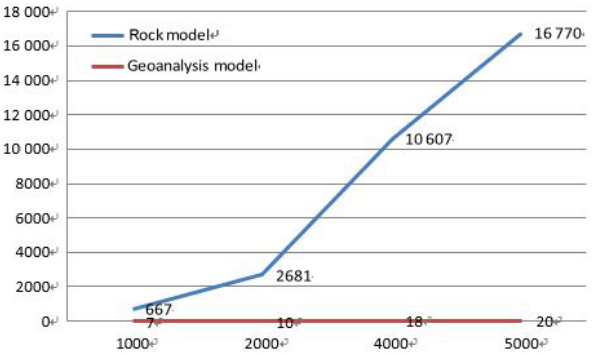
Figure 8. Time requirement for data queries (latitude and longi- tude).